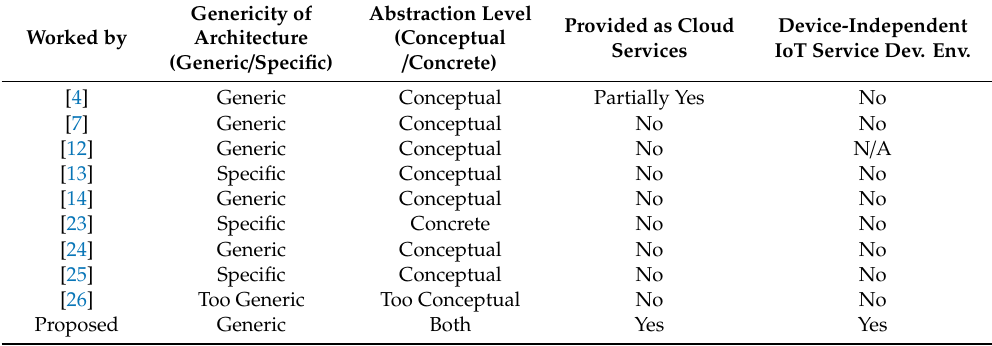
Table 1. Comparison of previous research and the proposed middleware framework for Internet of Things (IoT)